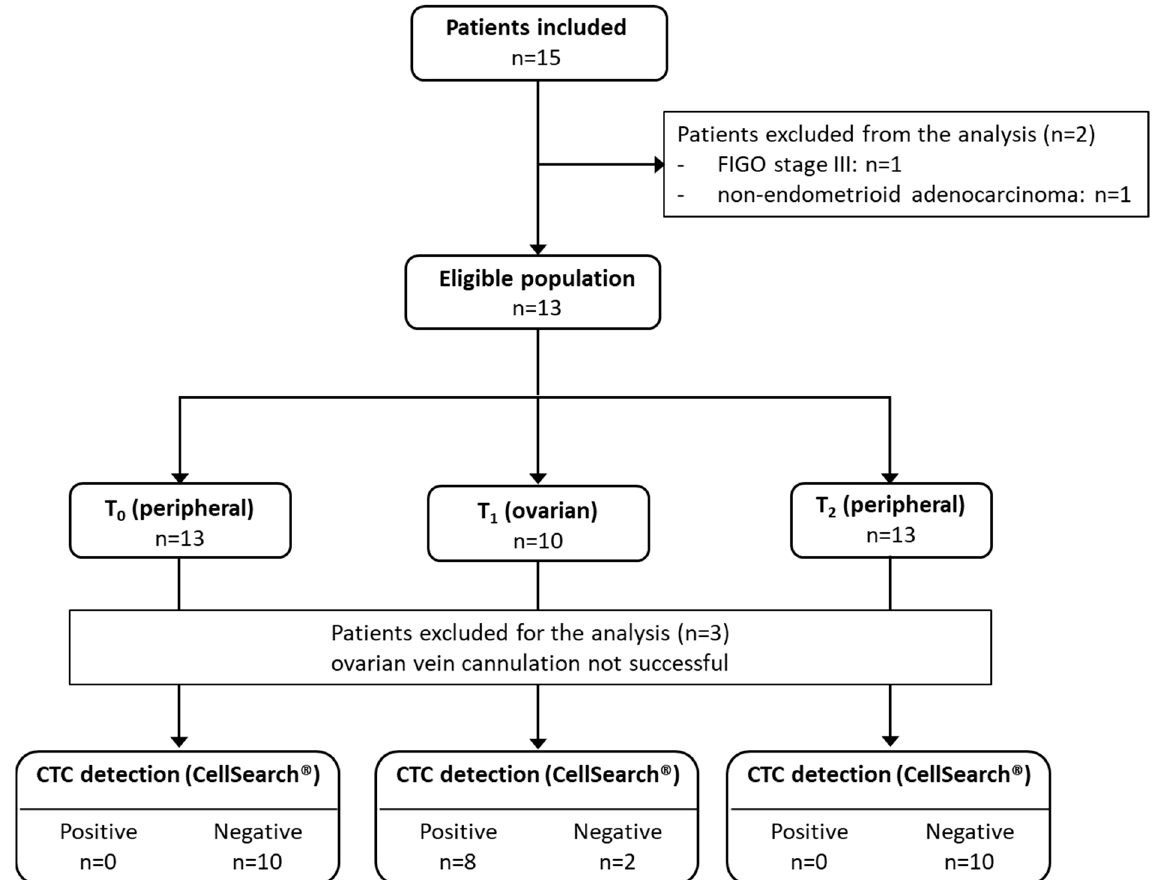
Figure 2. Flowchart showing the number of included and evaluable patients. Ten patients remained for the final analysis. Their clinicopathologic characteristics are summarized in Table 1. Table 1. Patients’ characteristics ( n = 10).